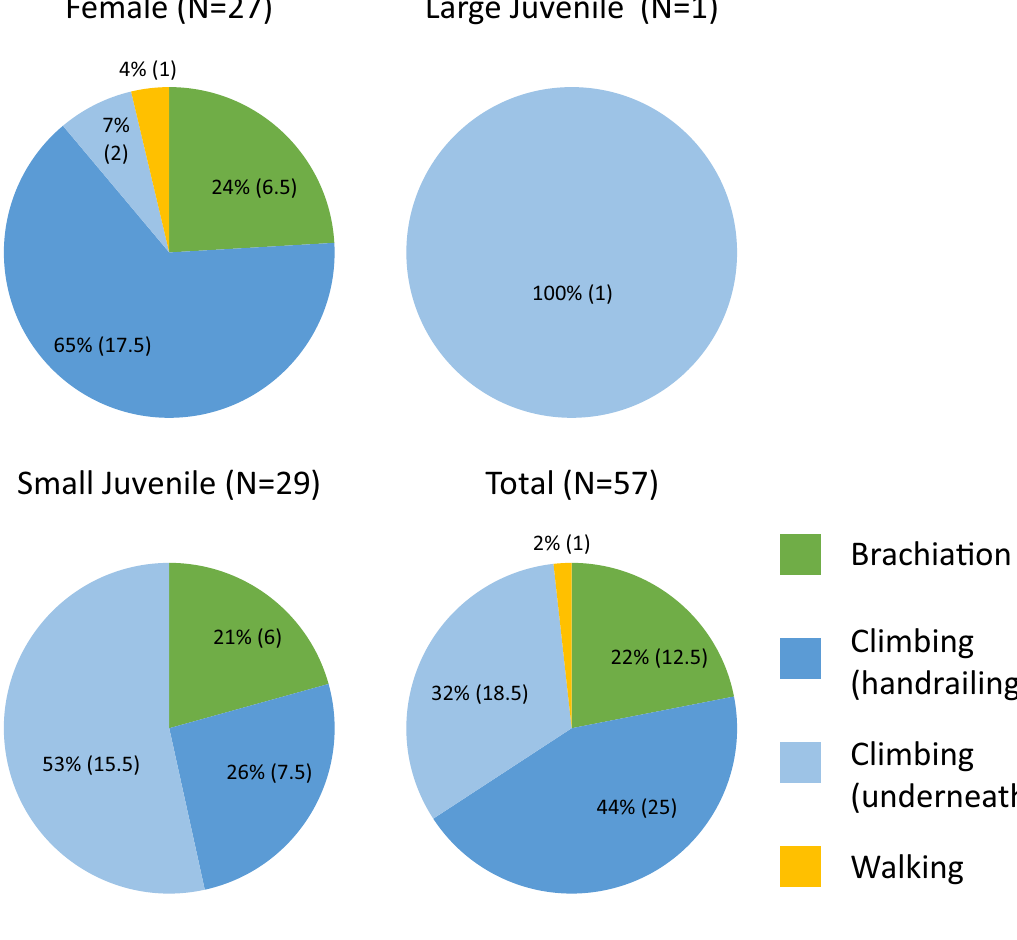
Figure 3. Age–sex difference in dominant form of locomotor mode on canopy bridge by the Hainan gibbon group. N is total number of individual crossing recorded by camera trap. Bridging was only used for entering and leaving the canopy bridge, and is excluded for